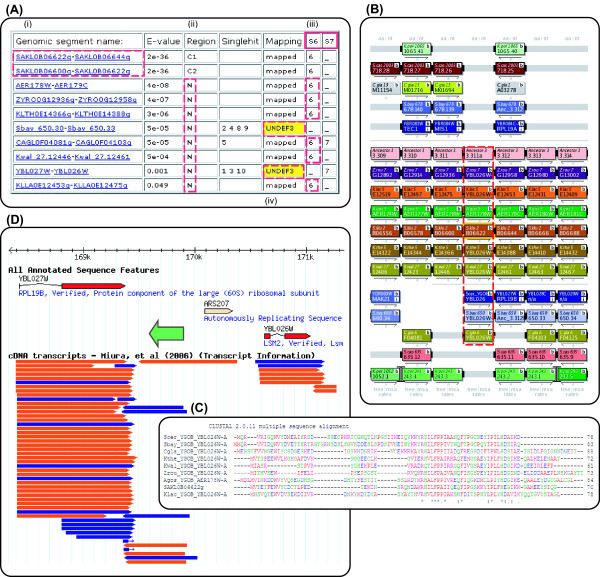
Orthologs of the L. kluyveri gene SAKL0B06622g discovered in eight species. (A) Output for web SearchDOGS with SAKL0B06622g used as a query. (i) The dashed box highlights the genomic segment containing the query. (ii) The letter N indicates the hits to noncoding regions in other species; C1 and C2 indicate coding regions. (iii) S6 and S7 refer to segments of the Ancestral genome. Genomic segments in other species that map to the same Ancestral segments constitute an OGS group. Six noncoding hits map to the same ancestral region (S6) as the query (dashed red boxes) and the seventh, located between YBL027W and YBL026W in S. cerevisiae, can be mapped to an adjacent ancestral region. (iv) 'UNDEF3' for the S. bayanus and S. cerevisiae genomic segments indicates that they have undergone some rearrangement relative to the Ancestor. The Ancestral segments to which they map are listed as "singlehit" if they are not shared with any other species. (B) YGOB screenshot after addition of the new genes, which are indicated by the dashed box. An ortholog of this gene is also inferred to have existed in the Ancestral genome because it is present in both non-WGD and post-WGD species. (C) ClustalW multiple sequence alignment [45] of the inferred protein sequences from nine species. (D) Location of the newly inferred S. cerevisiae gene YBL026W-A (green arrow), superimposed on a screenshot of the relevant region of chromosome II from SGD [46]. Eight expressed sequence tags from Miura et al. [16] indicate transcription of the gene.